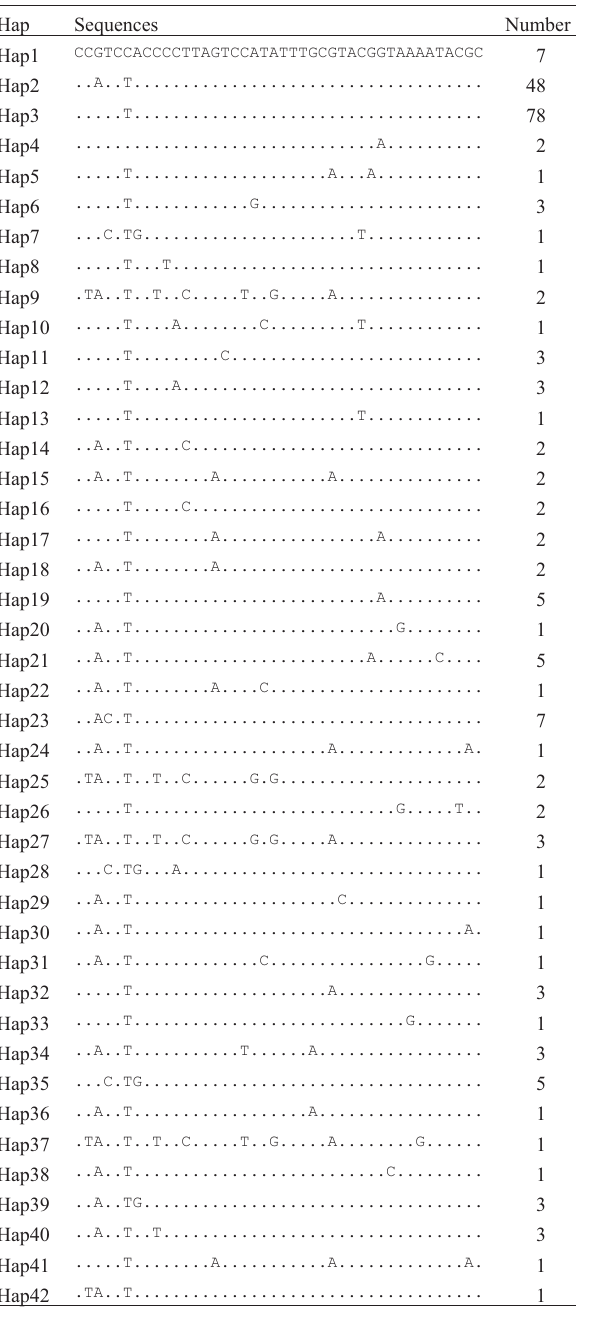
Table 1 - Haplotype (Hap)frequencies in Cynoscion acoupa